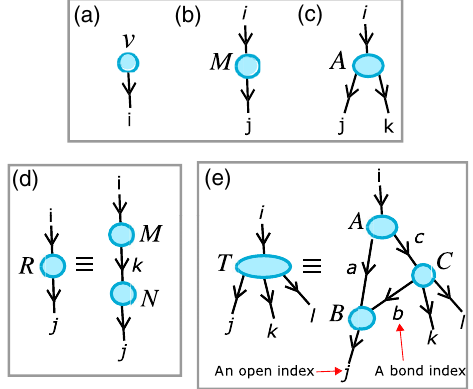
FIG. 1. Graphical representation of tensors and tensor operations. (a) A vector j v i ≡ (d) Matrix multiplication, Eq. (4). (e) Example of a more general tensor contraction, Eq. (5). Two types of indices are distinguished in a contraction: open indices that emanate only from one tensor and are left uncontracted, and bond indices that connect two tensors and get summed